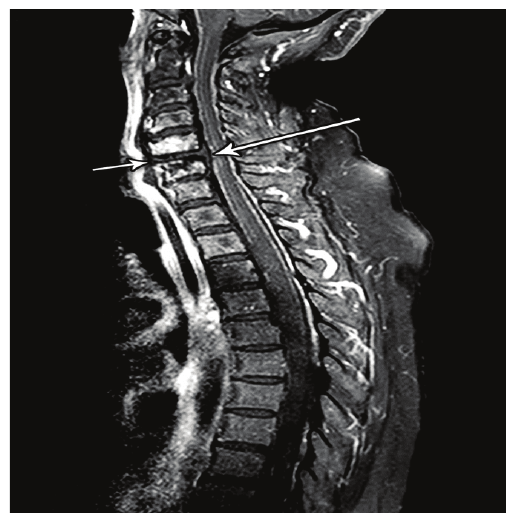
Figure 3: T1 MRI with fat suppression after IV Gadolinium in sagittal plane, demonstrating prevertebral collection (short arrow), with extension through the disk space into the epidural space (long